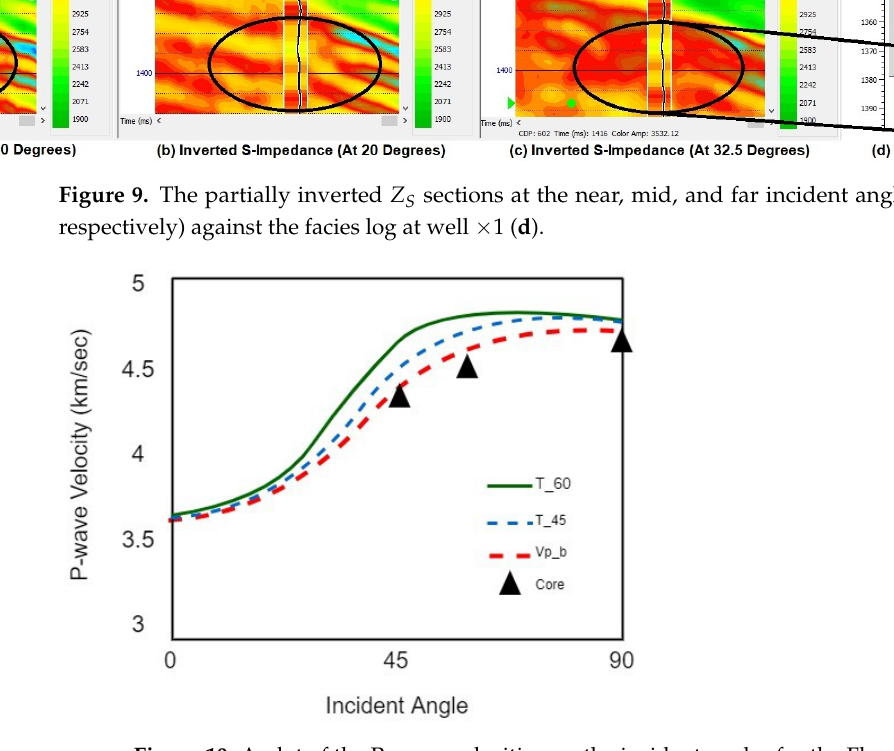
Figure 10. A plot of the P-wave velocities vs. the incident angles for the Floyd